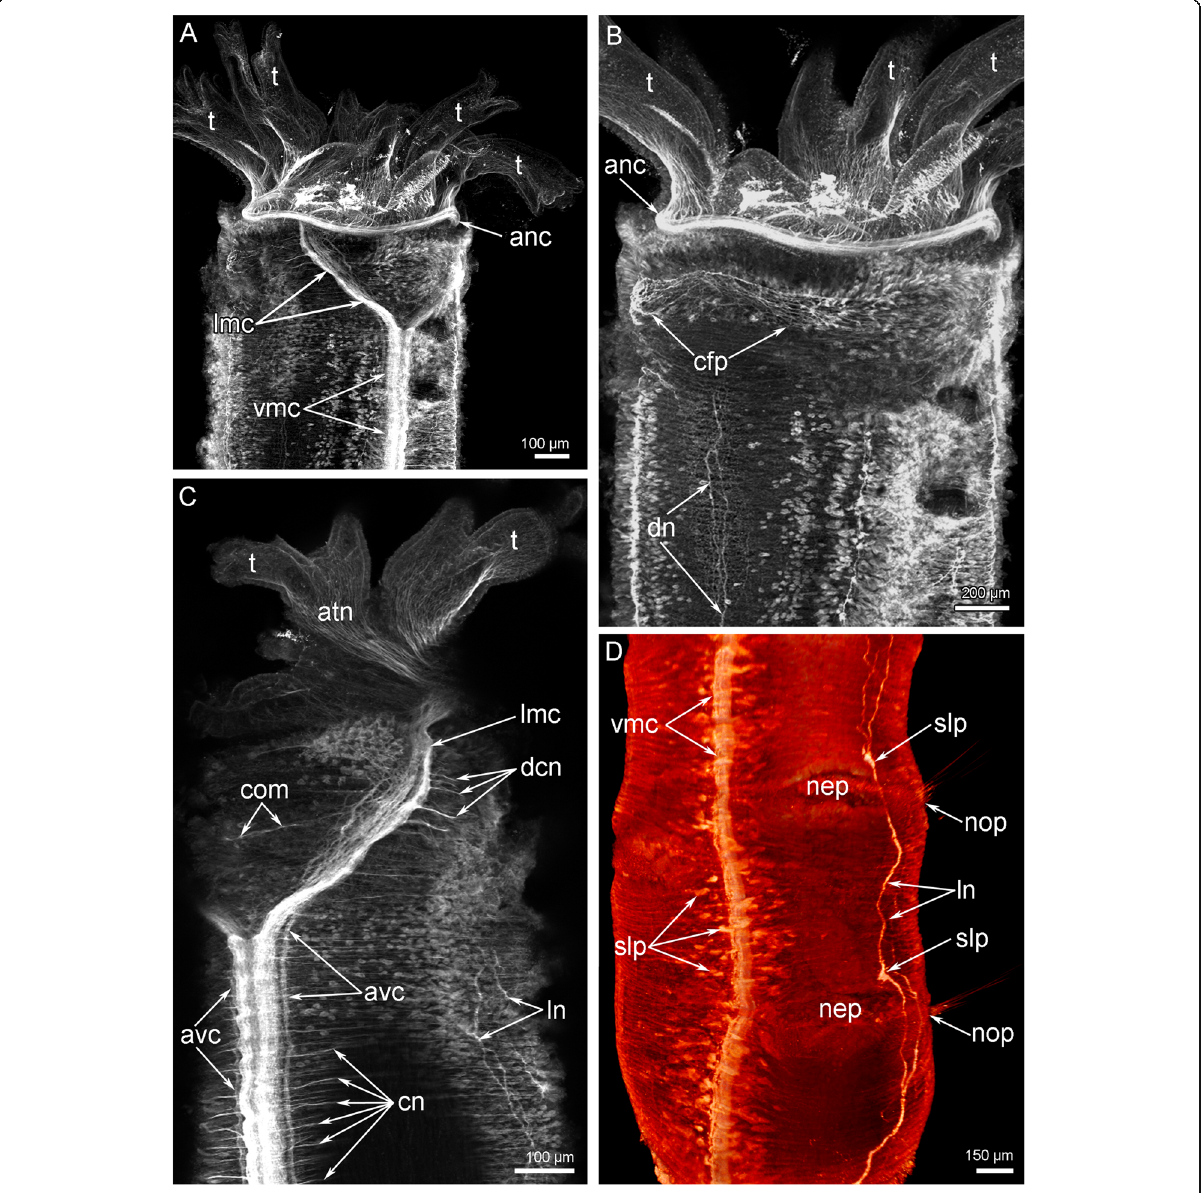
Fig. 10 Details of the nerve element location in the head and adjacent segments of Owenia borealis . CLSM data: Z-projections ( A - C ) after immunostaining against acetylated alpha-tubulin (grey) and volume rendering ( D ) after immunostaining against serotonin (orange). A A head with tentacle crown viewed from the ventral side. B A head with some tentacles viewed from the dorsal side. C Left portion of the head viewed from the ventral side. D A portion of the body near the head viewed from the left. Abbreviations: anc – outer ring of the anterior nerve center; atn – aboral tentacle nerves; avc – peripheral zones of the ventral medullary cord; com – ventral commissure; cfp – collar fold dorsal nerve plexus; cn – cross nerve; dcn – dorsal cross nerve; dn – dorsal neurites; lmc – lateral medullary cord; ln – lateral nerve; nep – neuropodia; nop – notopodia; slp – serotonin-like immunoreactive lateral perikarya; t – tentacle; vmc – ventral medullary